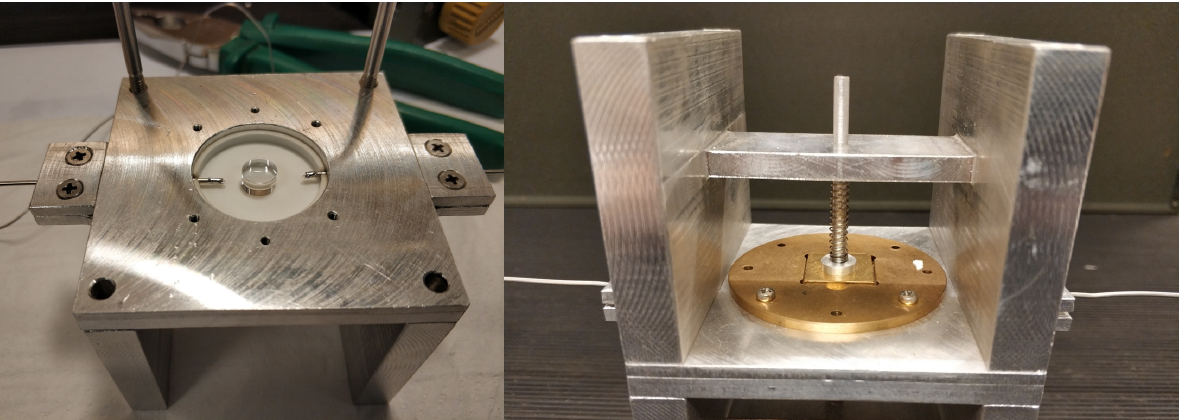
Figure 4. Vertical straight section of the designed DR. All the dimensions are in mm.